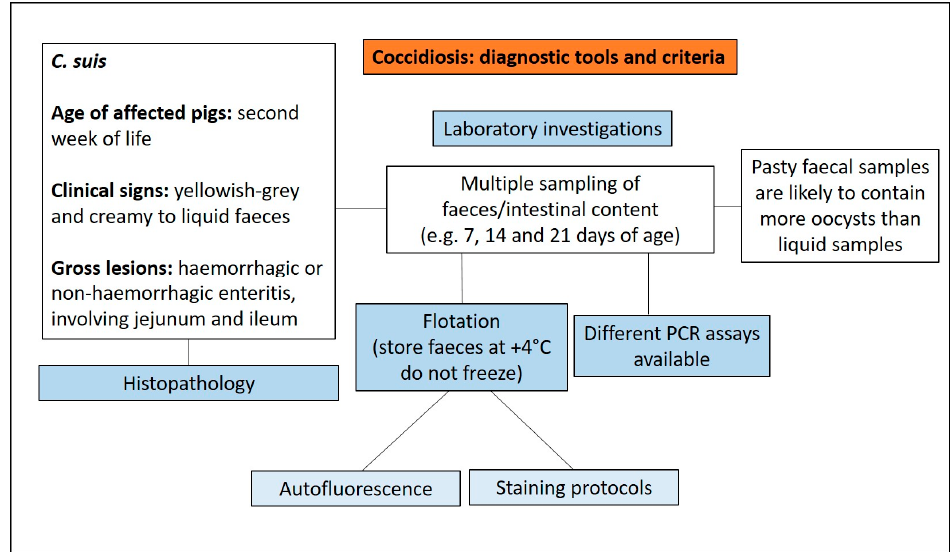
Figure 15. Diagnostic algorithm for the diagnosis of